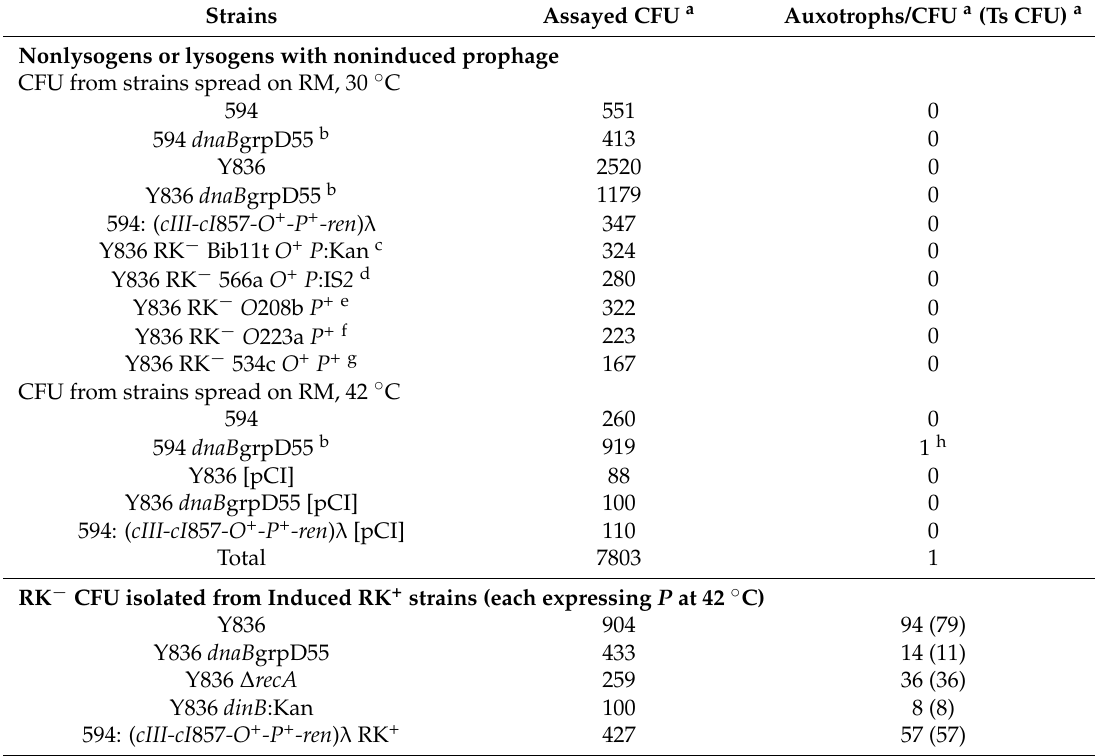
Table 3. Stab assay screen for auxotrophic colony forming units (CFU). Assayed CFU